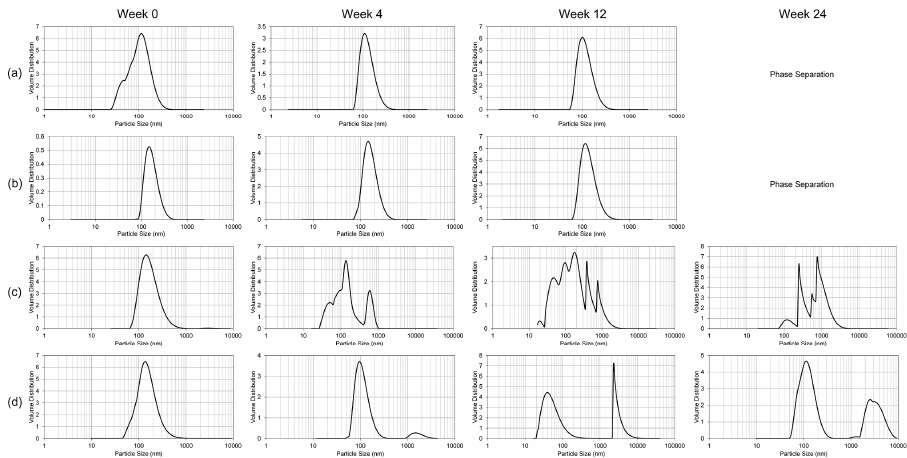
Figure 2. Particle size distribution over time for ( a ) liquid blank NE; ( b ) liquid GT3 NE; ( c ) lyophilized blank NE; and ( d ) lyophilized GT3 NE stored at 25 °C.